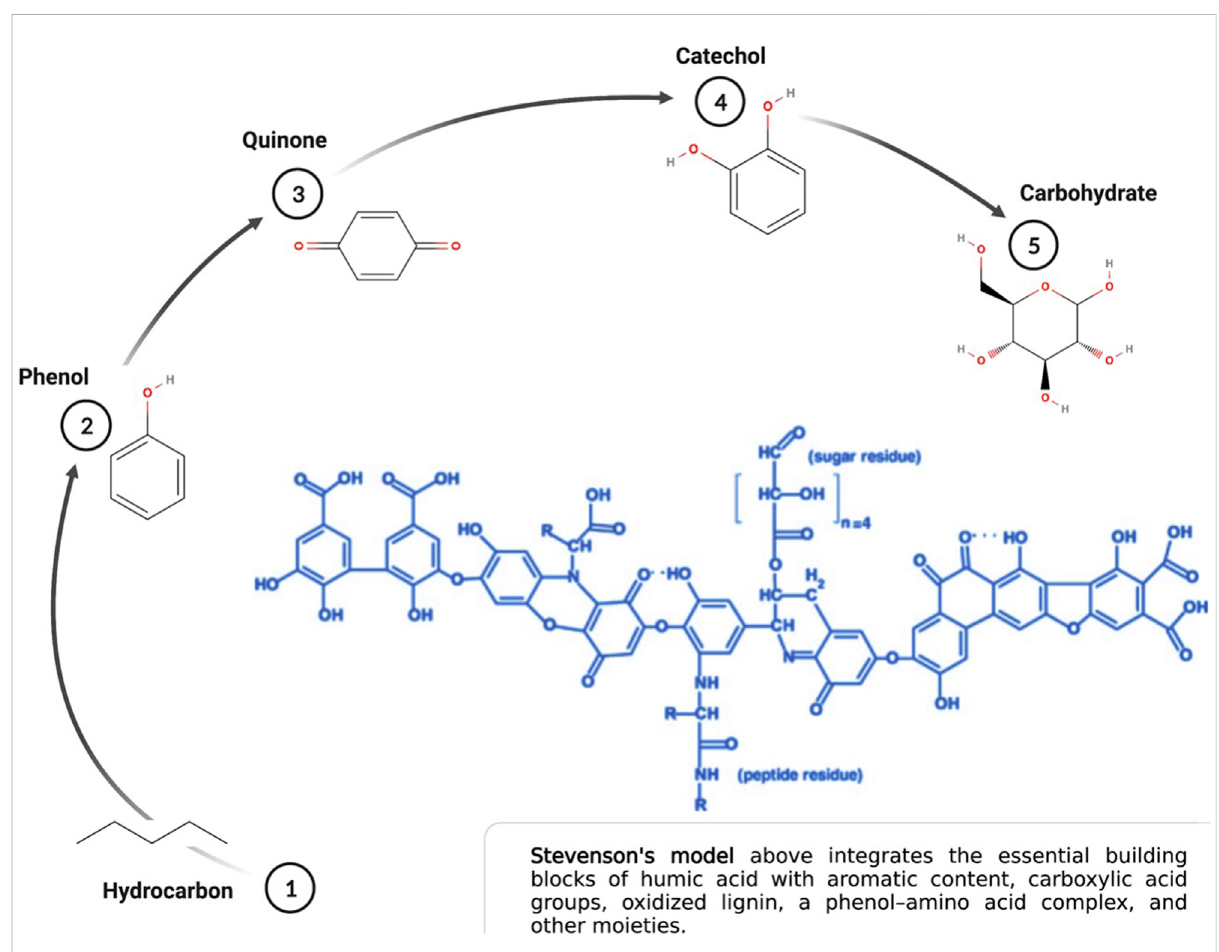
Essential building blocks of humic acid. Created with